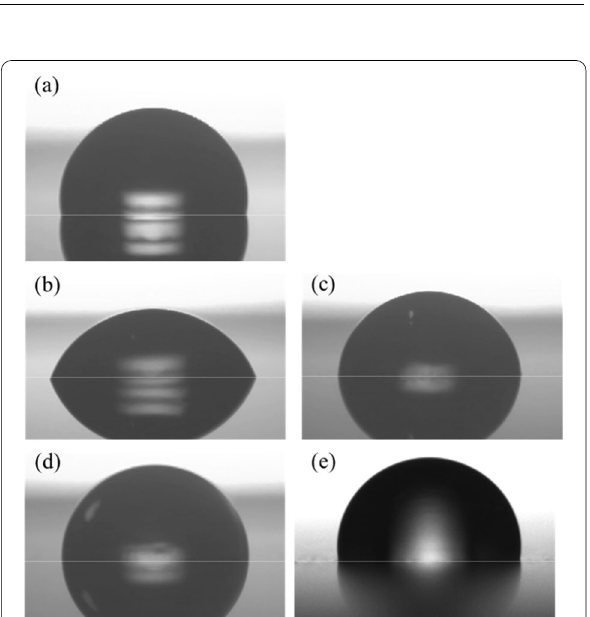
Fig. 3 Images for evaluating the WCA of control and FPB-treated surfaces. a Control, WCA WCA 85.4°, d FPB-3, WCA =